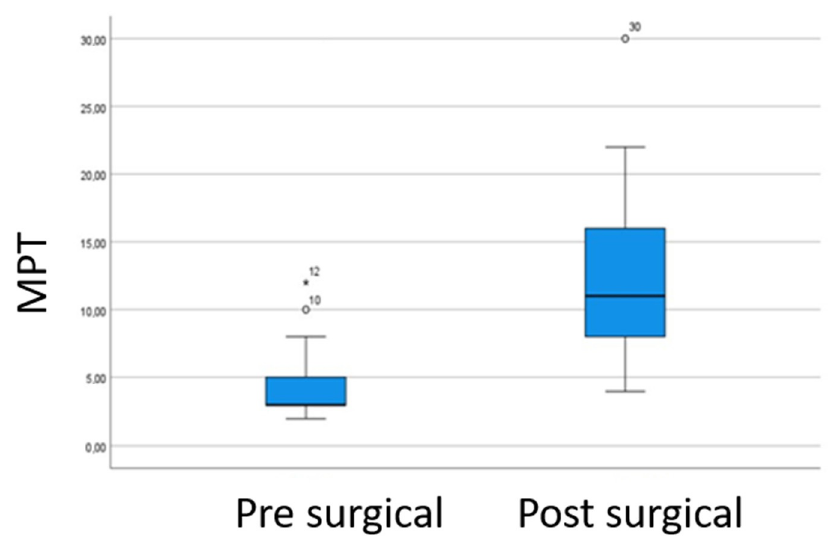
Figure 5. Comparison of the pre ‐ and post ‐ surgical MPT values. The post ‐ surgical MPT values were higher than the pre ‐ surgical, indicating improvement in the glottal closure.